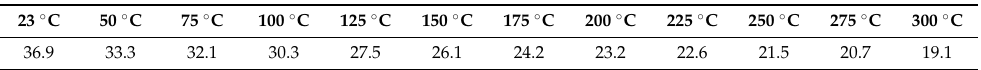
Figure 14. Numerical values of maximum compressive forces from stage III—compression at elevated temperature. Table 8. Experimental values of maximum compressive forces [kN] determined from compression at elevated